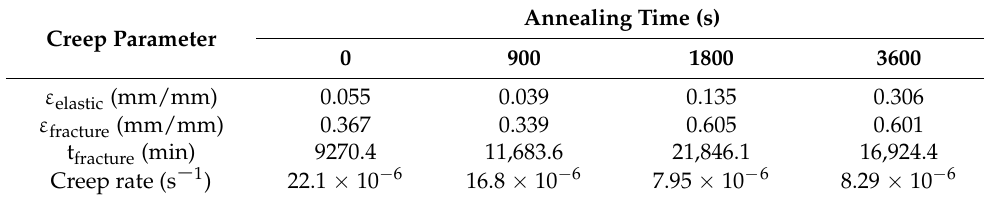
Table 3. Creep parameter of 253 MA ASS after annealing at 1100 ◦ C with variations in the annealing time. Creep